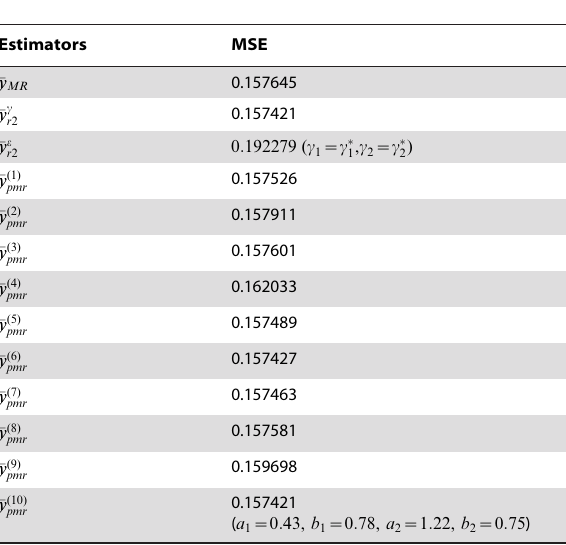
Table 3. MSE Values of Ratio